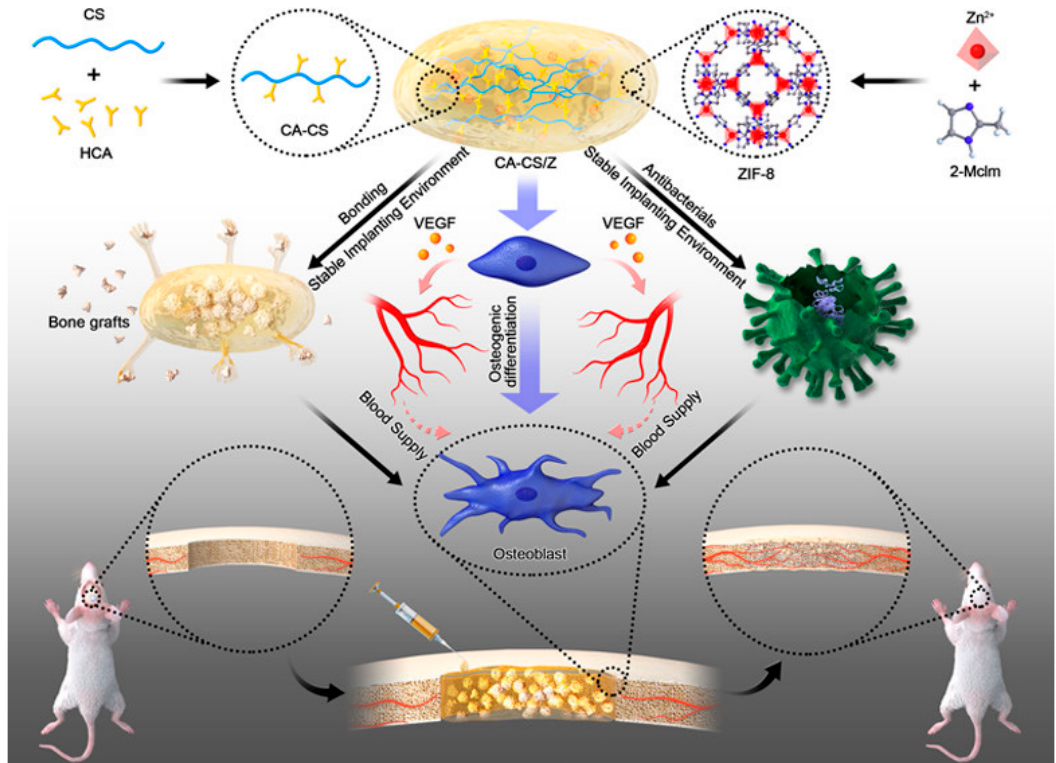
Figure 4. Scheme of the fabrication of CA-CS/Z hydrogels with acceptable adhesion properties and antibacterial properties, enhancing the stability of the implanting environment after bone transplanta- tion. HCA, hydrocaffeic acid; 2-Mclm, 2-methylimidazole; VEGF, vascular endothelial growth factor (Reprinted with permission from Ref. [113]. Copyright 2020 American Chemical